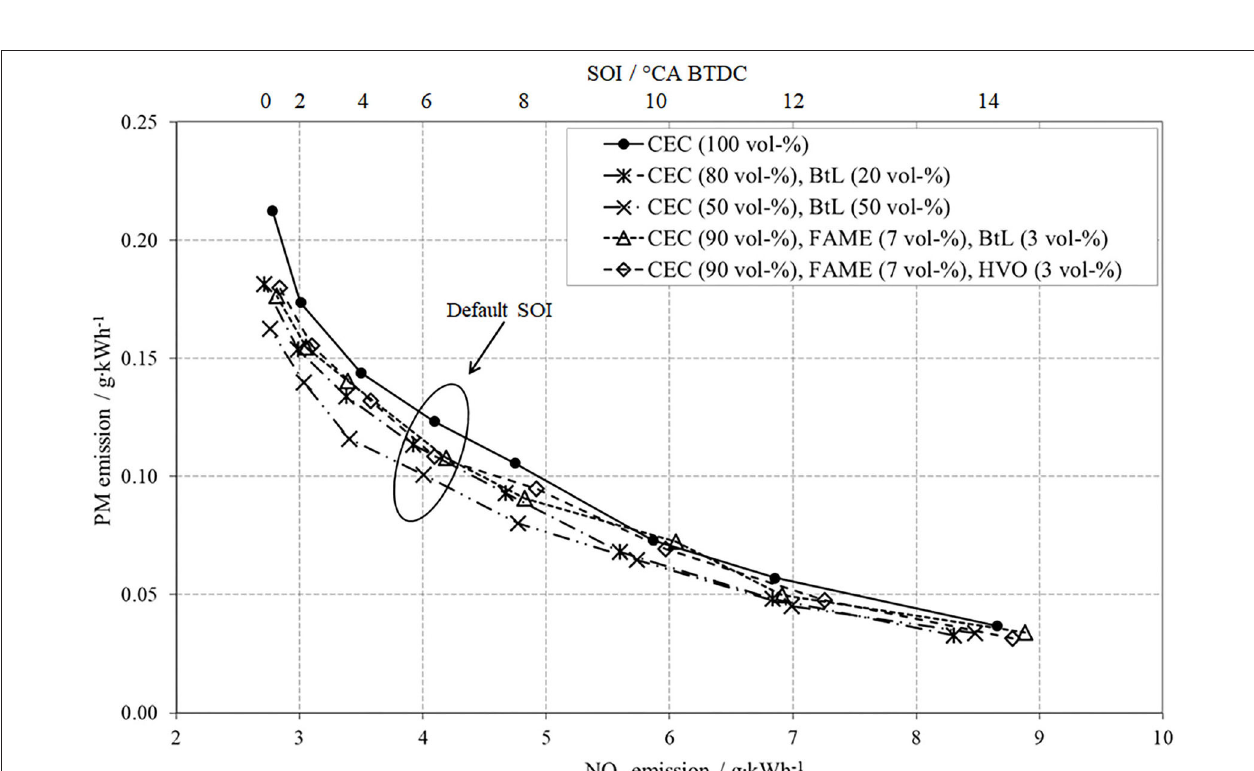
FIGURE 9 | Specific NO x - and PM-emissions at 3,000 min − 1 and 8 bar BMEP with varying SOI.